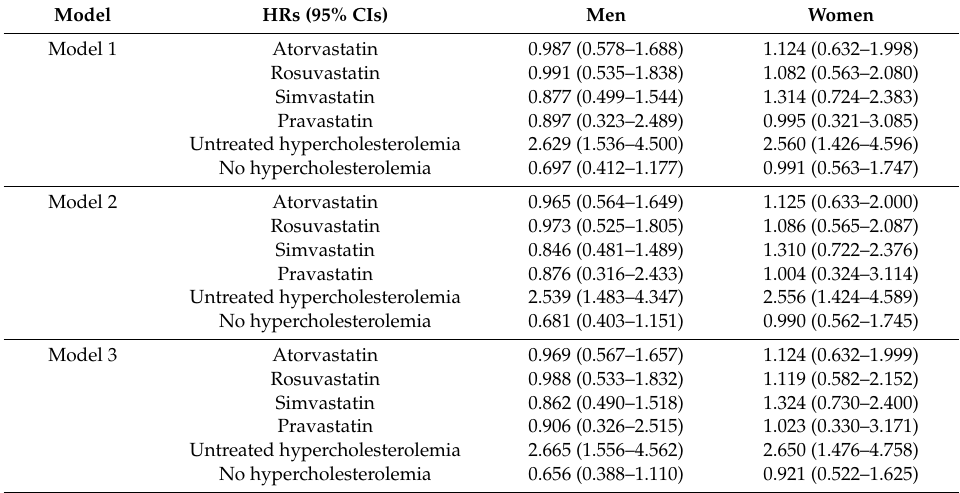
Table 2. Cox-proportional hazard regression model for composite outcomes (cardiocerebrovascular diseases and related deaths), compared with pitavastatin.